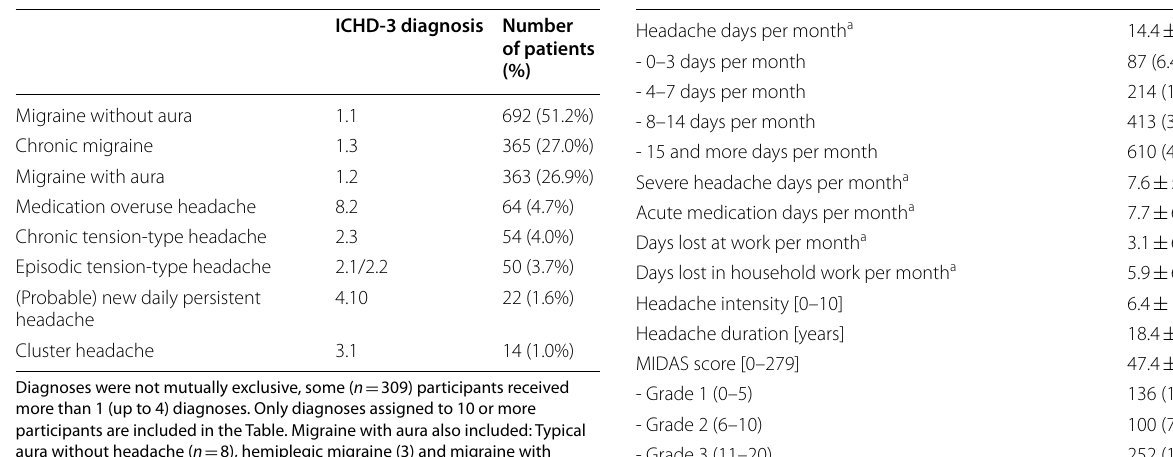
Table 3 Headache characteristics and results of